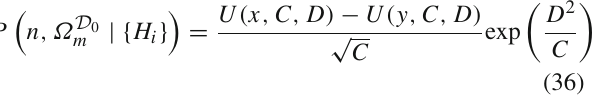
Fig. 2 The 1 σ , 2 σ and 3 σ confidence regions of the effective parameters n , Ω D 0 m , and H D probability density